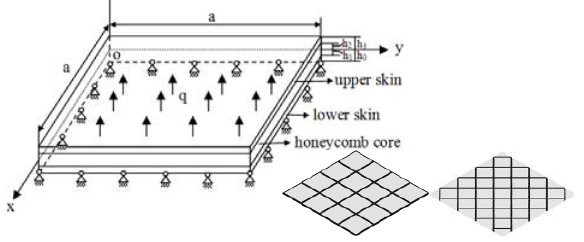
Fig.7. Sandwich panel with square and rhombic cores